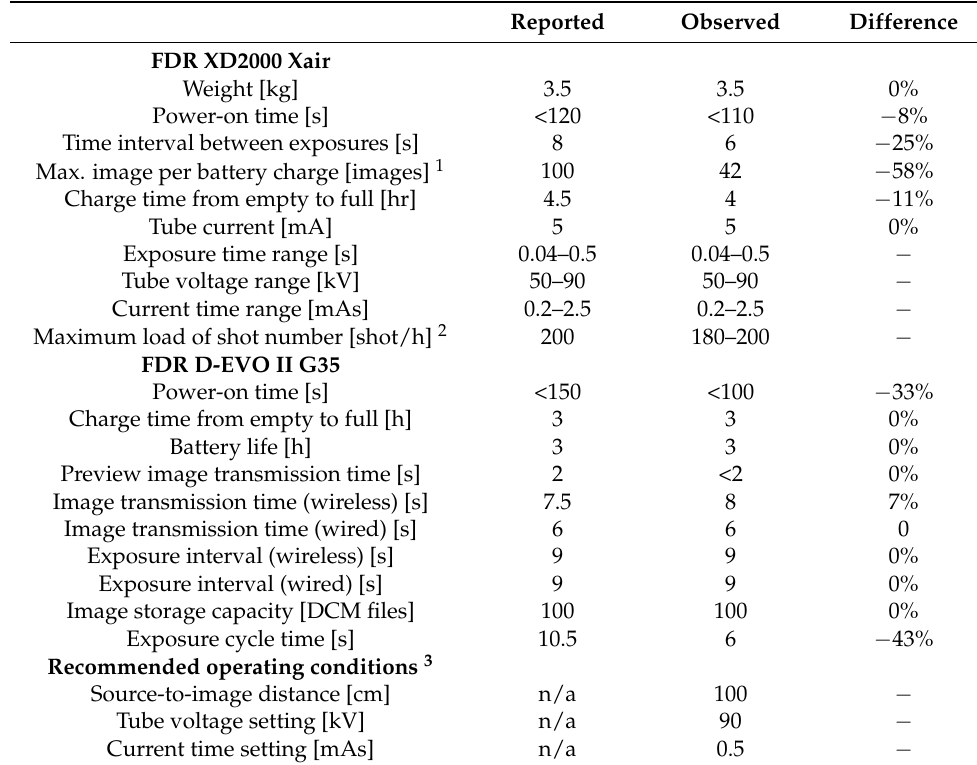
Table 1. Key ultra-portable X-ray system characteristics and performance indicators as reported in the user manual and observed during